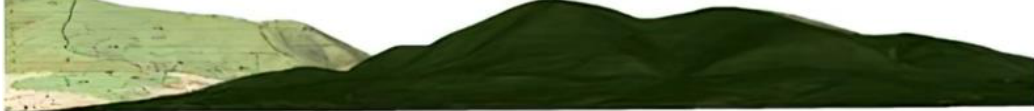
Figure 20. Textured DTM model — profile view from the east side .